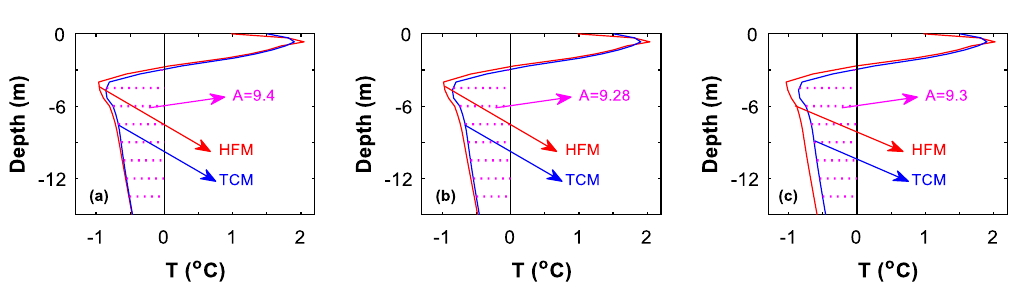
Figure 8. The southern side-slope borehole temperature profile predicted by HFM is compared with that by TCM. Date: on October 27. ( a ) 5th year, ( b ) 10th year, and ( c ) 50th year.